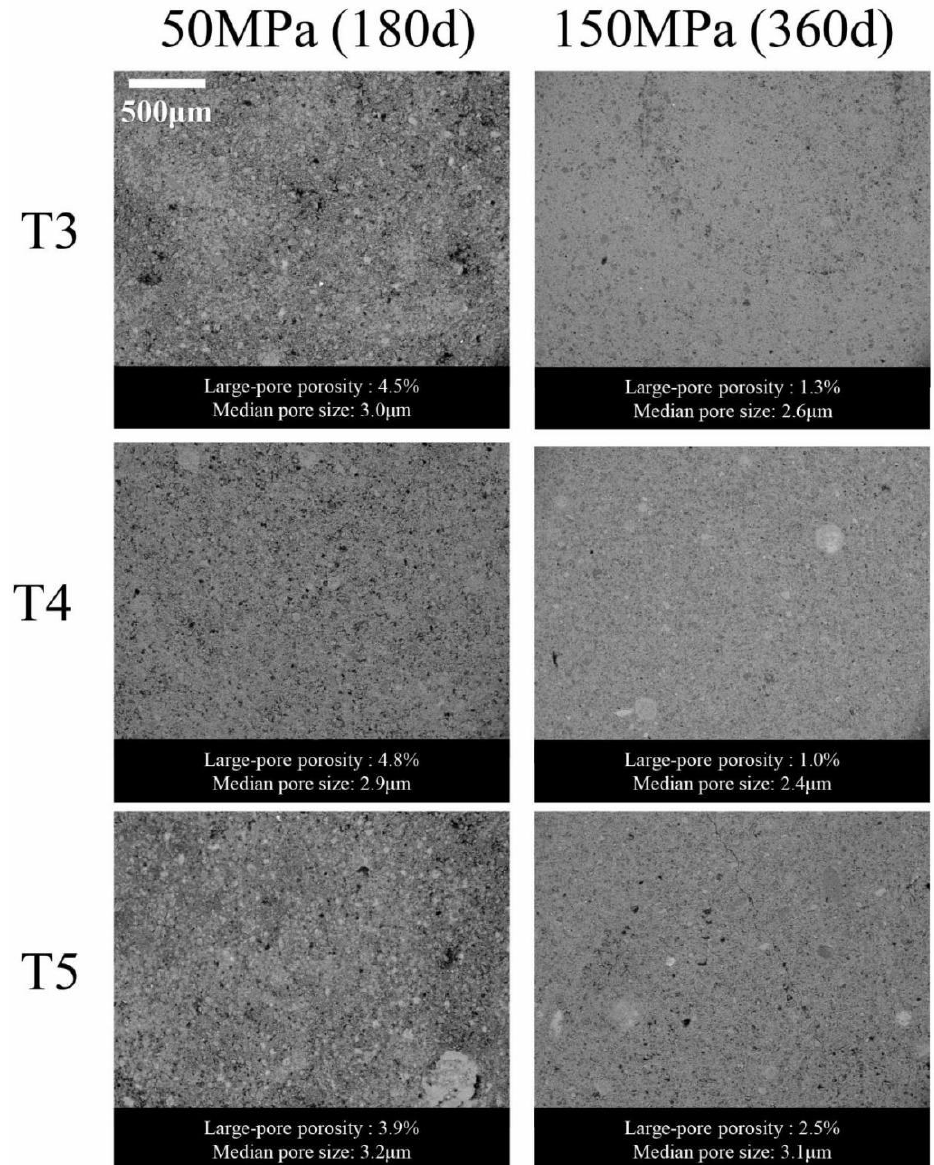
Figure 12. SEM-BSE analysis of slurries T3 to T5 showed that higher curing pressure resulted in smaller pore size and lower porosity in long-term cured samples. (T3: control; T4: latex fiber, T5: nano-graphene).